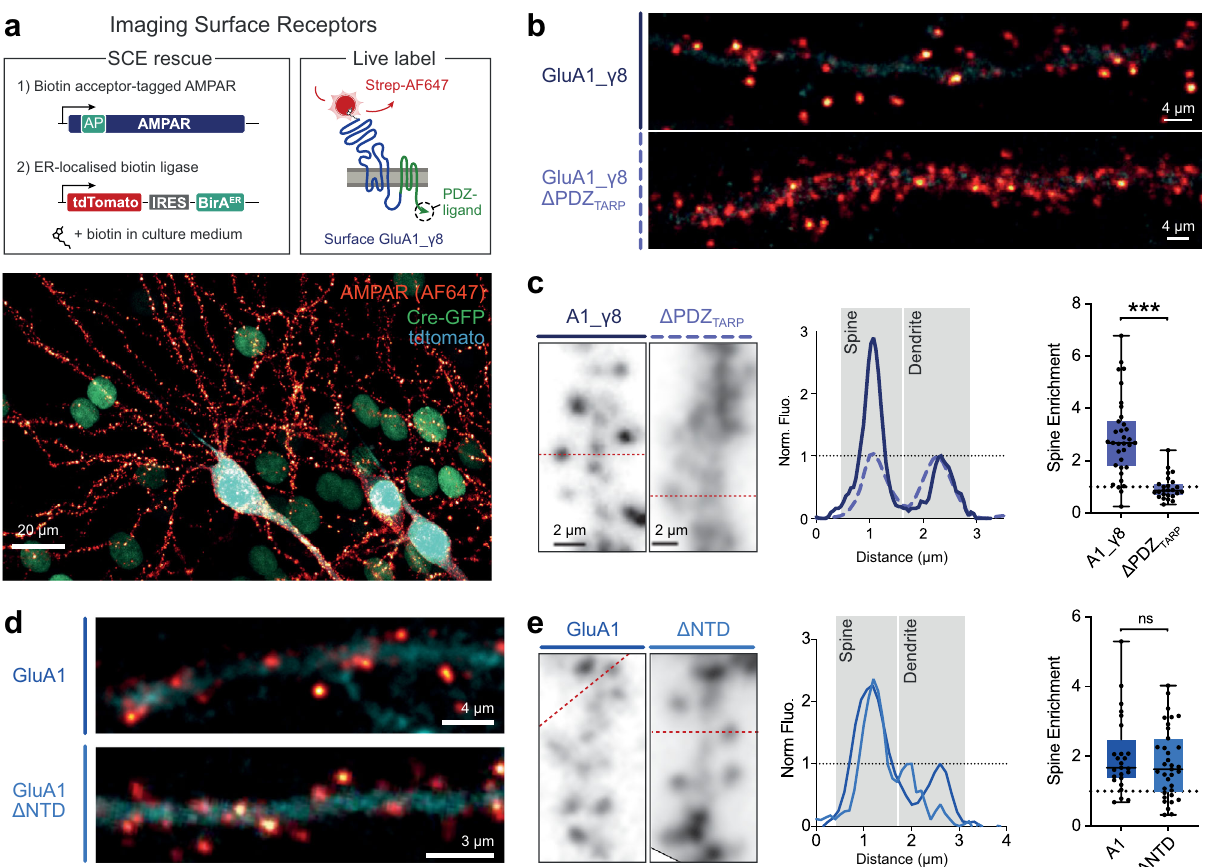
Fig. 4 TARP PDZ interactions accumulate receptors at synaptic sites. a Strategy for fl uorescent labelling of surface AMPARs on rescue of knockout neurons using streptavidin labelling of biotinylated AMPARs (left), including schematic of AMPAR-TARP-tandem con fi guration (right). ER-localised BirA biotinylates the acceptor peptide (AP) on the receptor N-terminus. Example image (bottom) of surface AMPARs (red) in Cre-transduced (green) slices after co-rescue with tdTomato cell marker (blue). Similar results were obtained in 24 cells across four conditions and three preparations, presented across this fi gure, with additional representative images in Supplementary Figure 6. b GluA1_ γ 8 receptors accumulate in spines along the dendrite, while TARP PDZ mutation causes redistribution of receptors to the dendritic surface (see c for details). c Line pro fi les (left) of AMPAR fl uorescence across spine and dendrite demonstrate enrichment of PDZ-containing receptors in spines. Quanti fi cation of receptor distribution (right) shows accumulation of GluA1_ γ 8 but not GluA1_ γ 8 Δ PDZ in spines. Box indicates 25 – 75%, whiskers represent max to min, with median represented as a centre line. (GluA1_ γ 8: 2.67 (1.73, 3.53) (median, (25%, 75%), n = 34 spines over seven cells (four slices per condition, two preparations); GluA1_ γ 8 Δ PDZ: 0.86 (0.67, 1.15), n = 25 spines over fi ve cells; p < 0.0001). d NTD deletion of GluA1 (GluA1 Δ NTD) did not prevent AMPAR accumulation in dendritic spines as seen by surface receptor imaging (see e for details). e Line pro fi les (left), and spine enrichment quanti fi cation (right) demonstrate spin localisation of GluA1 Δ NTD (GluA1: 1.67 (1.34, 2.48), n = 25 spines over fi ve cells (three slices per condition, one preparation); GluA1 Δ NTD: 1.63 (0.96, 2.52), n = 35 spines over seven cells; p < 0.52). Statistical signi fi cance was analysed using a Mann – Whitney test, *** indicates p < 0.001 and ns speci fi es no signi fi cance. Source data are provided as a source data fi